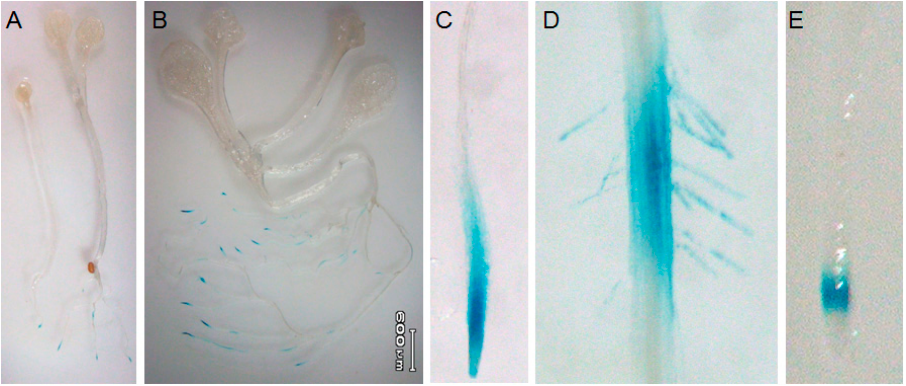
Figure 3. Gene expression pattern of AtTGG5 Prom::GUS . ( A ) Four-day-old seedlings; ( B ) a two-week-old plants; ( C ) a zoomed-in image of a root-tip showing the expression region of AtTGG5 Prom::GUS in the whole tip; ( D ) a zoomed-in image of a hairy zone; and ( E ) a zoomed-in image of a root-tip of AtTGG4 Prom::GUS presented here for easier comparison between AtTGG4 and AtTGG5 .